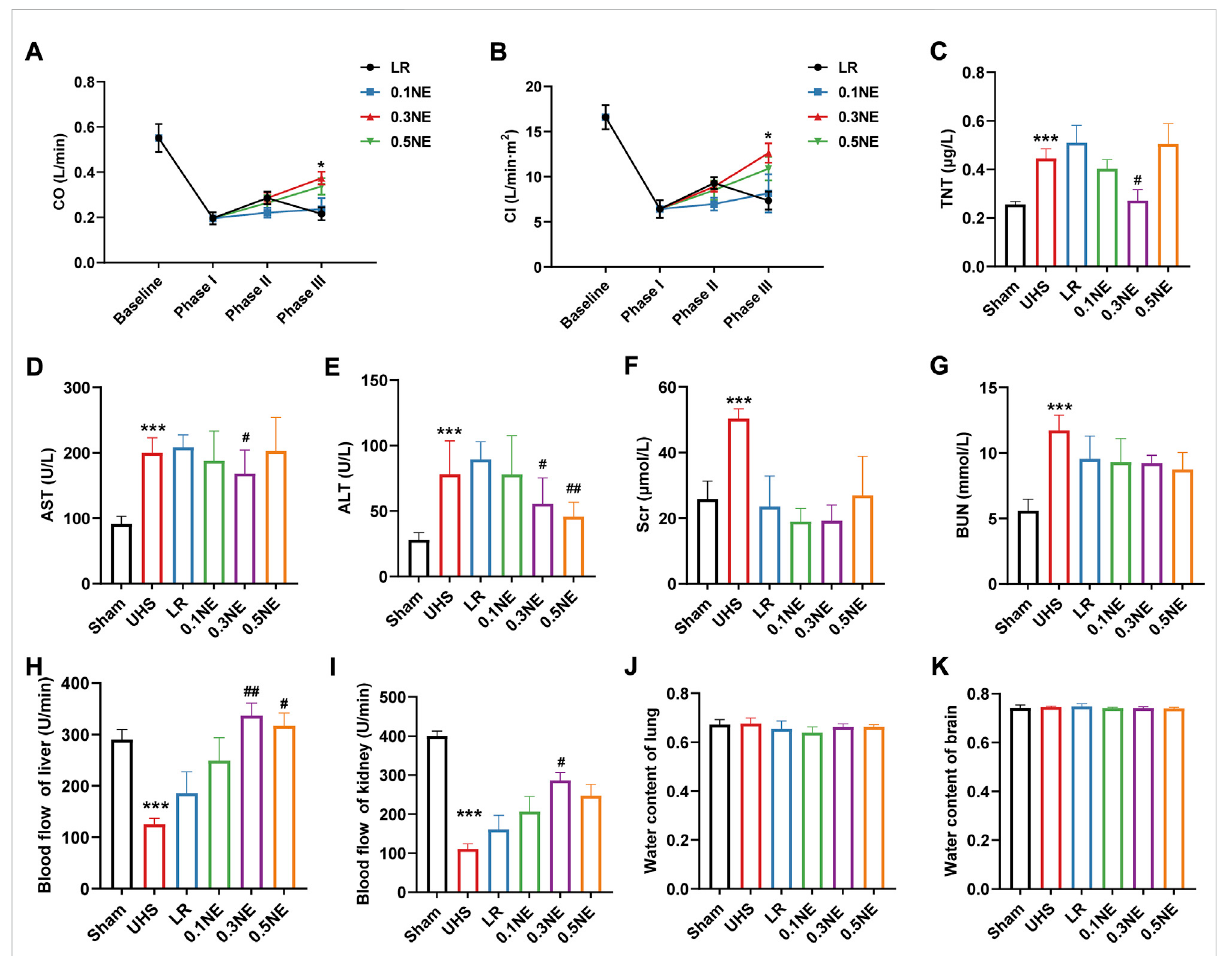
FIGURE 7 The effect of NE on vital organ functions following 1 h of hypotensive resuscitation. (A) CO. * p ＜ 0.05 as compared with LR group. (B) CI. * p ＜ 0.05ascomparedwith LRgroup. (C) TnT.*** p ＜ 0.001 ascomparedwith theSham group. # p ＜ 0.05ascomparedwith theLRgroup. (D,E) ASTand ALT. *** p ＜ 0.001 as compared with the Sham group. # p ＜ 0.05, ## p ＜ 0.01 as compared with LR group. (F,G) Scr and BUN. *** p ＜ 0.001 as compared with the Sham group. (H,I) Blood fl owof liver andkidney. *** p ＜ 0.001 as compared withthe Sham group. # p ＜ 0.05, ## p ＜ 0.01 as compared with LR group. (J,K) water content of the lung and